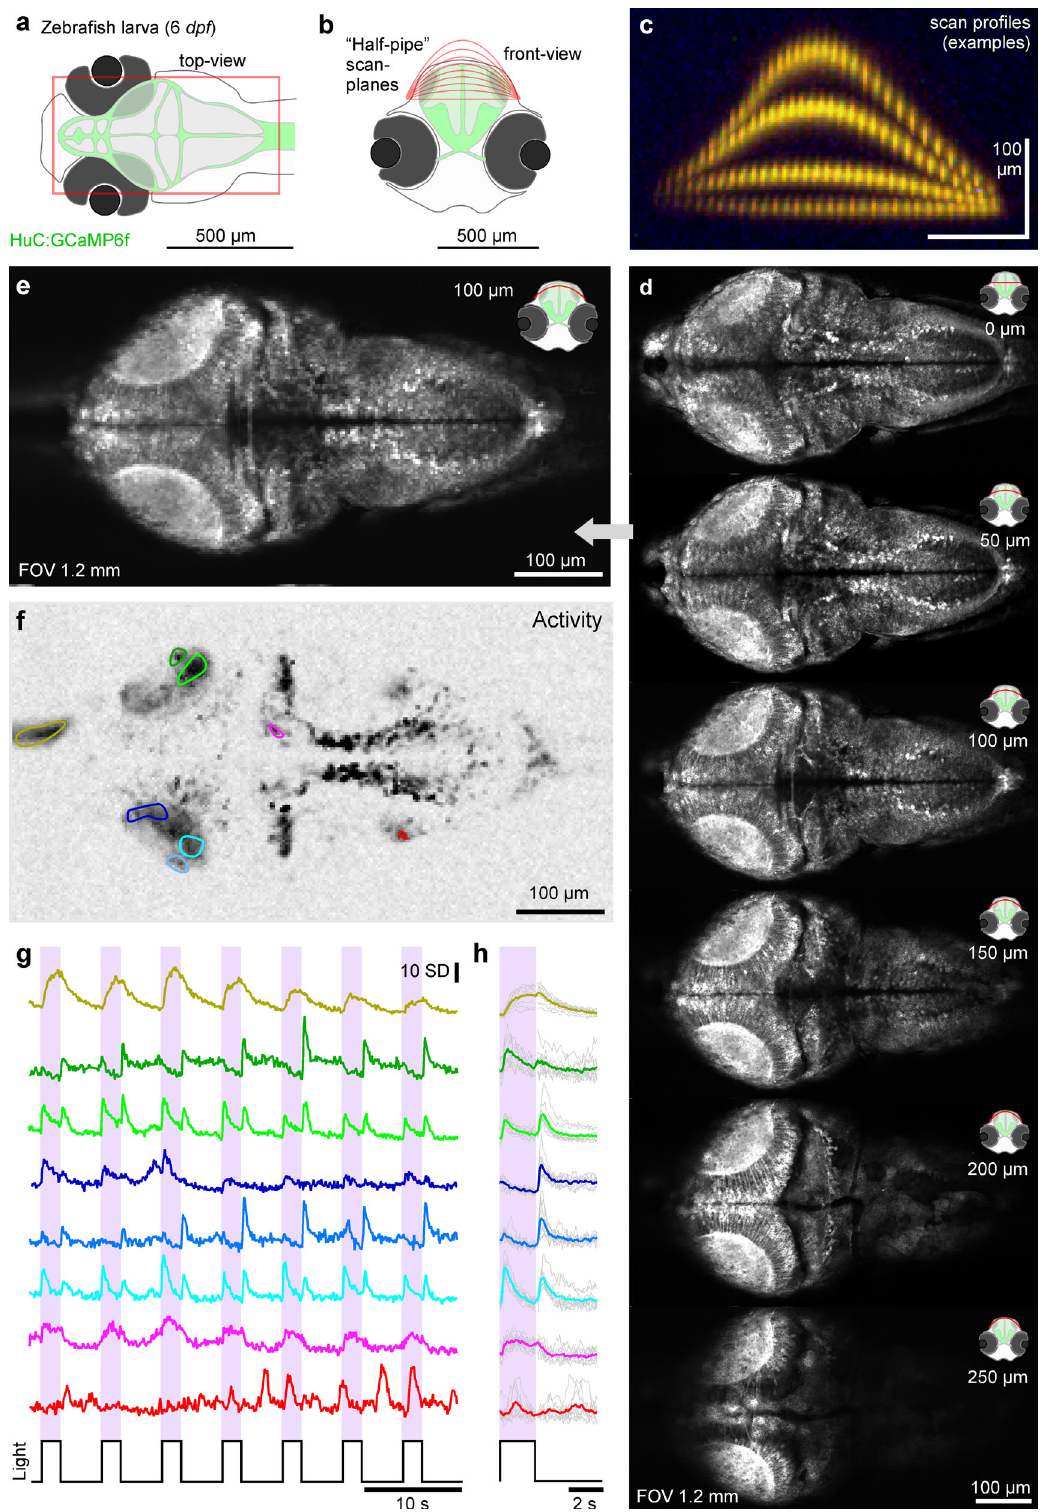
Fig. 7 2P plane-bending to image the in vivo larval zebra fi sh brain. a – c Schematic of HuC:GCaMP6f larval zebra fi sh brain viewed from top ( a ) and front ( b ) with scan planes indicated, and ( c ) example-scan-pro fi les. d nTC 1 512 × 1024 scans of a 6 dpf zebra fi sh brain with different plane curvatures, with peak axial displacement at scan centre as indicated. At curvatures ~100 – 150 µ m peak displacement the scan approximately traverses the surface of the tectum. e – h Mean ( e ), activity-correlation ( f , cf. Fig. 3c) and fl uorescence traces ( g , raw and h , event-triggered mean) from a 170 × 340 px scan (5.88 Hz) of the 100 µ m peak displacement con fi guration (image 3 in ( d )). The fi sh was presented with full- fi eld and spectrally broad (~360 – 650 nm) series of light- fl ashes. See also Fig.